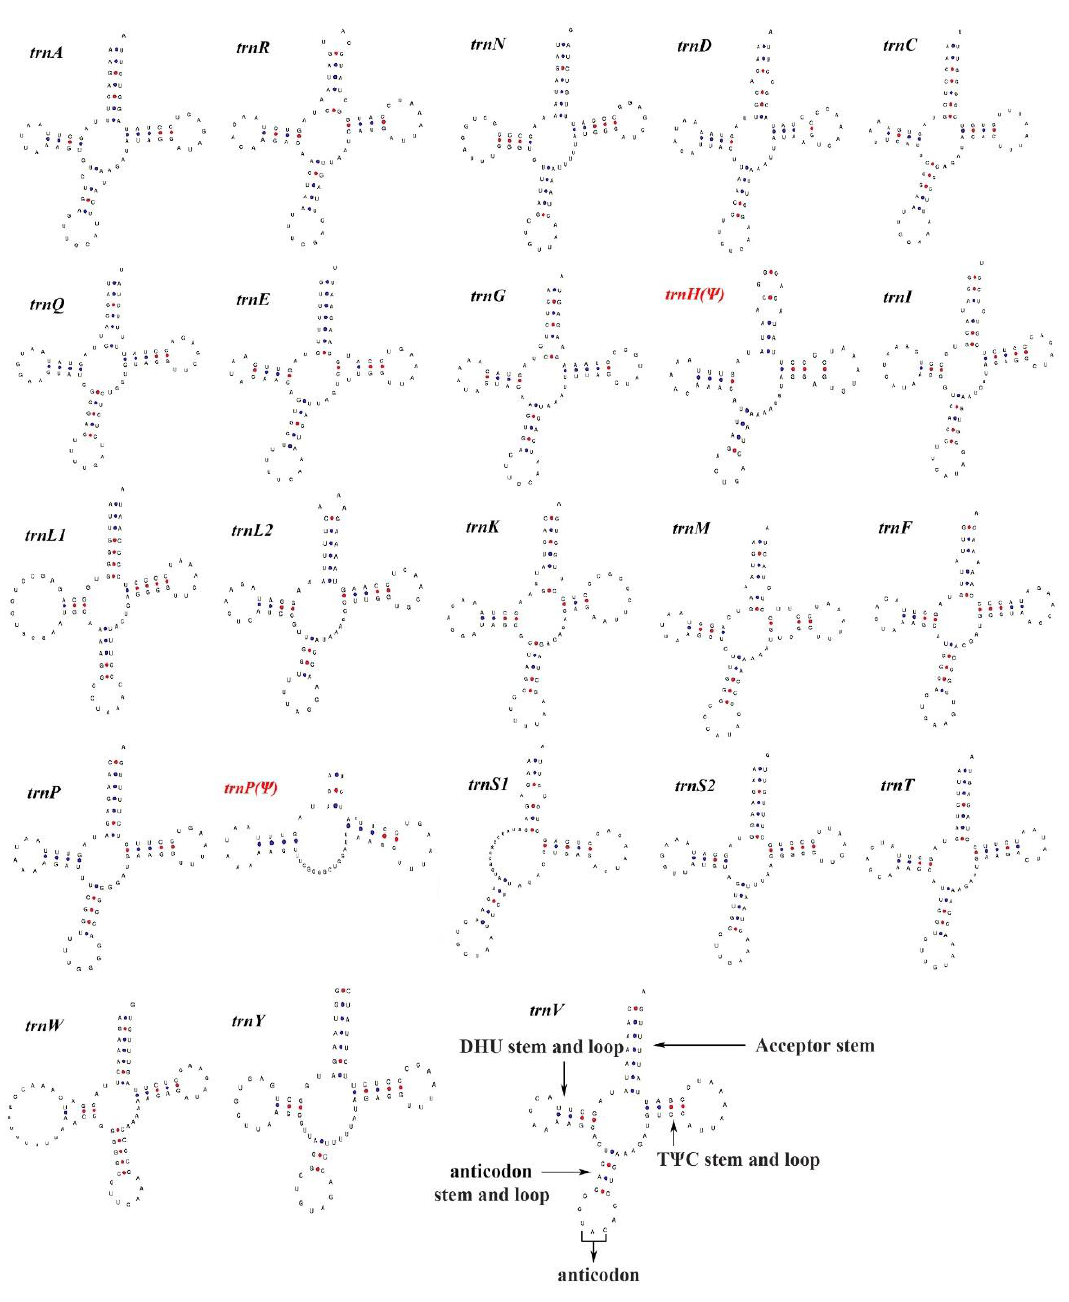
Figure 4. Putative secondary structures for 23 tRNA genes of P. m. peguense . The tRNA genes are labeled with standard abbreviations. Red font indicates degenerated tRNA genes.